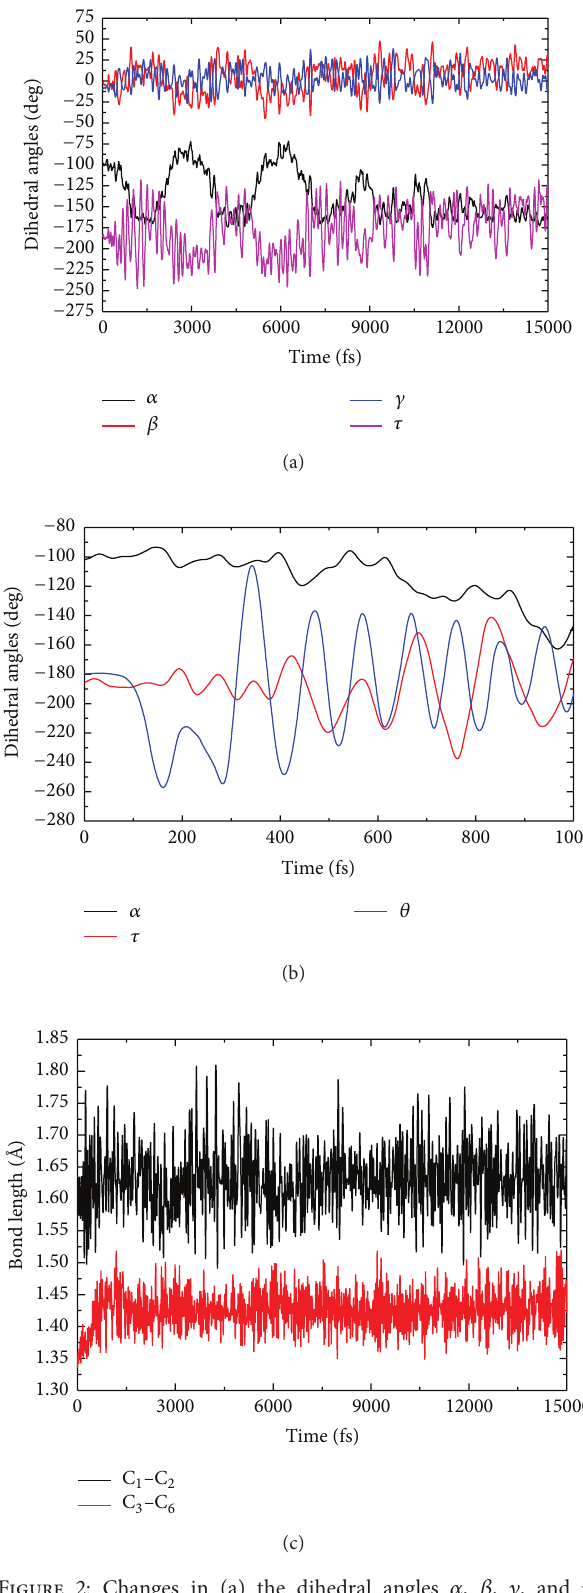
Figure 2: Changes in (a) the dihedral angles 𝛼 , 𝛽 , 𝛾 , and 𝜏 ; (b) 𝛼 , 𝜏 , and 𝜃 ; (c) C 1 –C 2 and C 3 –C 6 bond lengthens of cis-SP subjected excitation by a 80 fs (FWHM) laser pulse with a fluence of 0.188 kJ/m 2 and photon energy of 4.054